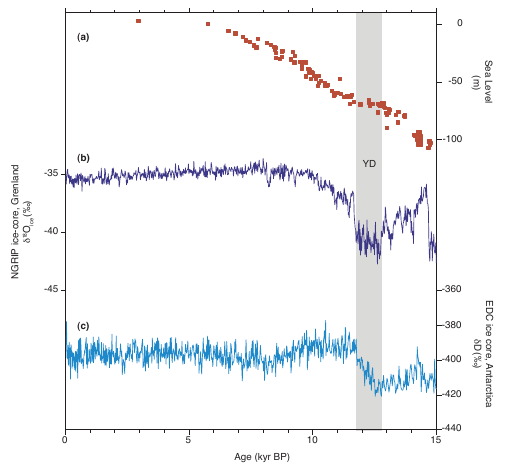
Fig. 1. Lateglacial and Holocene palaeoclimate records. (a) sea- level reconstruction (Lambeck and Chappell, 2001); (b) δ 18 O com- position of ice in the NGRIP ice core, Greenland (North Greenland Ice Core Project members, 2004); (c) δ D composition of ice in the EPICA Dome C (EDC) ice core (Jouzel et al., 2007). Grey band denotes the position of the Younger Dryas (YD) stadial.